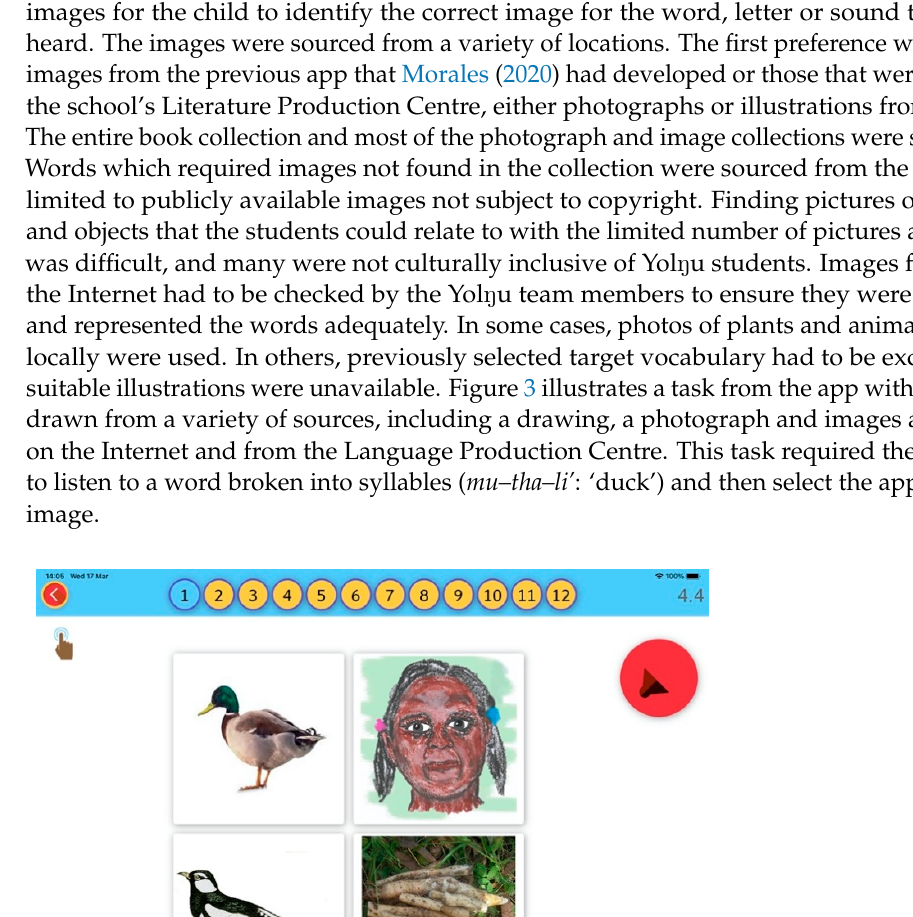
Figure 4. An image from the app (Identifying Letter Sounds).